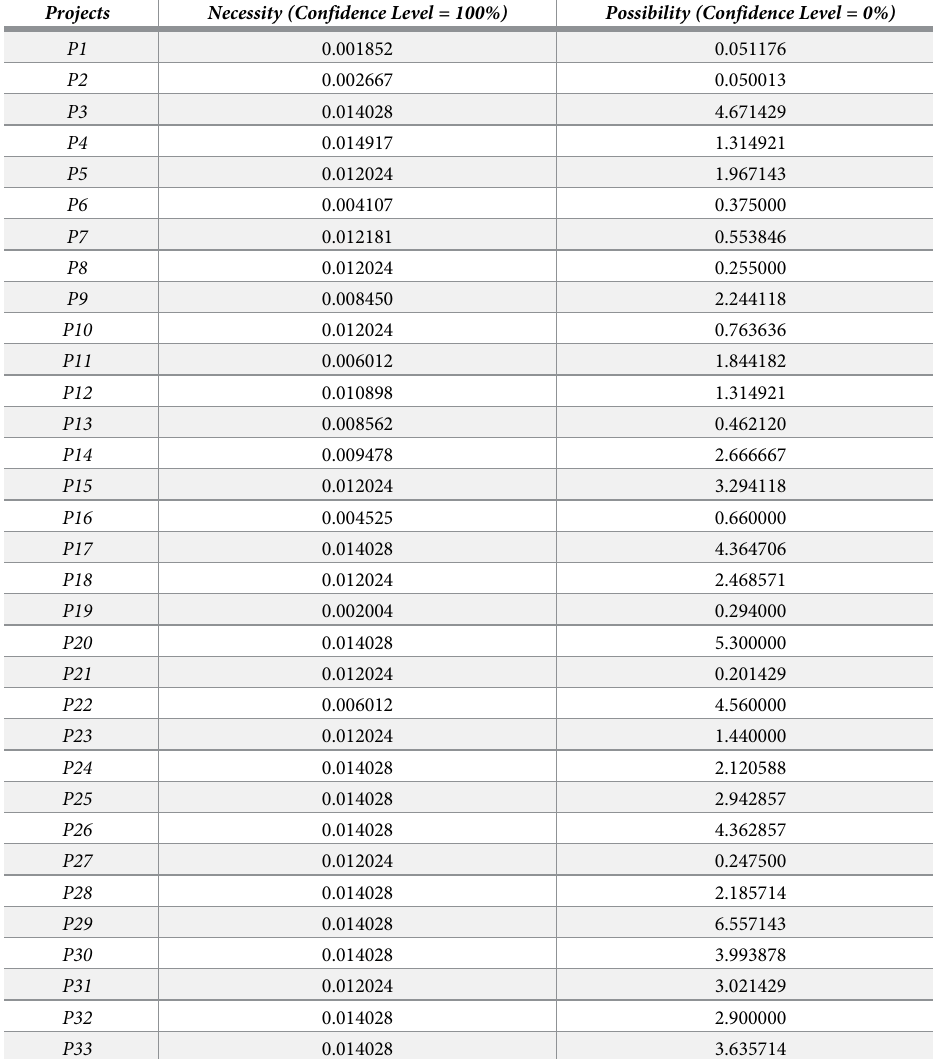
Table 6. Projects efficiencies in optimistic and pessimistic fuzzy approaches.